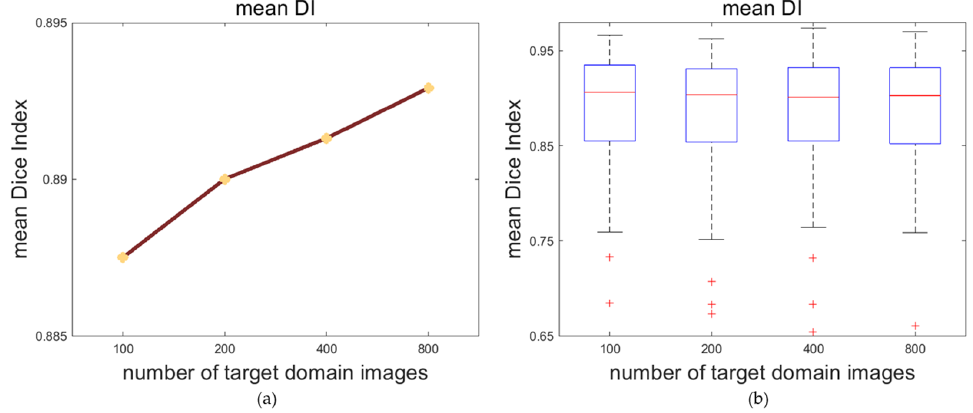
Figure 5. The mean Dice Index (DI) for segmentation results of the MACS trained with different numbers of target domain images. ( a ) The line graph of the mean DI. ( b ) The boxplot of the mean DI.